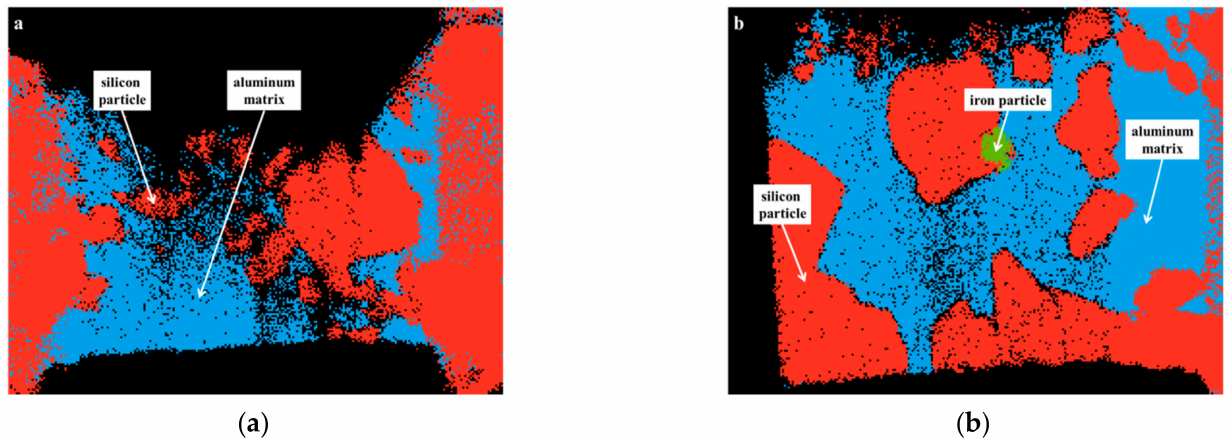
Figure 3. Transmission Electron Microscopy-Energy-dispersive X-ray spectroscopy (TEM-EDS) images of Al-42Si AR ( a ) and Al-42Si TT ( b ); aluminum: blue, silicon: red, iron: